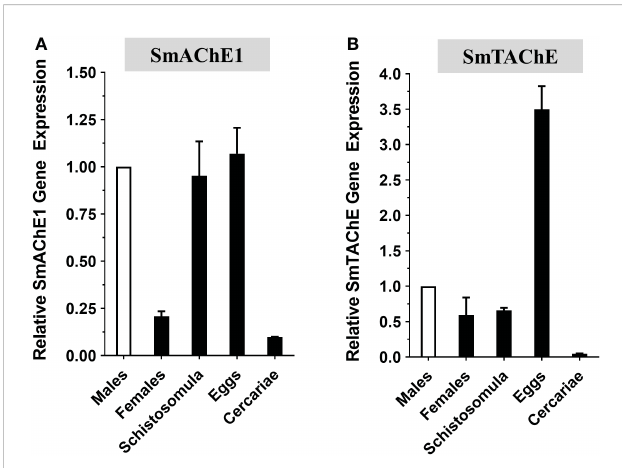
FIGURE 5 Developmental expression of acetylcholinesterase genes in different S. mansoni life stages as determined by RT-qPCR. (A) SmAChE1 gene expression. (B) SmTAChE Gene expression. All values are relative to the gene expression level of male parasites, set at 1 (Mean ± SD,